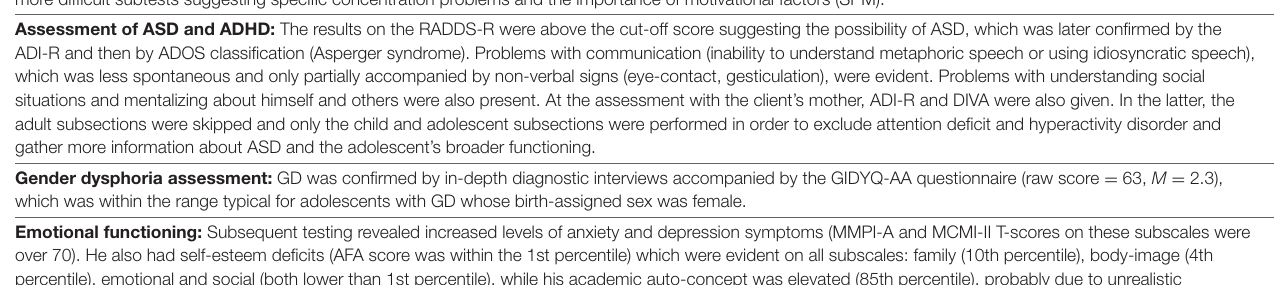
TABLE 1 | The results of the clinical psychological assessment. Intellectual and cognitive abilities : The results revealed intact visual-motor performance (BGT), average attention span and working memory, low intellectual abilities (25th percentile) with disharmonic profiles of subtests due to inconsistent mental effort and therefore lower reliability of the results. Performance was better on more difficult subtests suggesting specific concentration problems and the importance of motivational factors (SPM). Assessment of ASD and ADHD: The results on the RADDS-R were above the cut-off score suggesting the possibility of ASD, which was later confirmed by the ADI-R and then by ADOS classification (Asperger syndrome). Problems with communication (inability to understand metaphoric speech or using idiosyncratic speech), which was less spontaneous and only partially accompanied by non-verbal signs (eye-contact, gesticulation), were evident. Problems with understanding social situations and mentalizing about himself and others were also present. At the assessment with the client’s mother, ADI-R and DIVA were also given. In the latter, the adult subsections were skipped and only the child and adolescent subsections were performed in order to exclude attention deficit and hyperactivity disorder and gather more information about ASD and the adolescent’s broader functioning. Gender dysphoria assessment: GD was confirmed by in-depth diagnostic interviews accompanied by the GIDYQ-AA questionnaire (raw score = 63, M = 2.3), which was within the range typical for adolescents with GD whose birth-assigned sex was female. Emotional functioning: Subsequent testing revealed increased levels of anxiety and depression symptoms (MMPI-A and MCMI-II T-scores on these subscales were over 70). He also had self-esteem deficits (AFA score was within the 1st percentile) which were evident on all subscales: family (10th percentile), body-image (4th percentile), emotional and social (both lower than 1st percentile), while his academic auto-concept was elevated (85th percentile), probably due to unrealistic self-perceptions. Personality assessment: Projective techniques (Rorschach test, scored with Rorschach Assistance Program (Ver. 3) by Virtual Psychology) revealed further information about the client’s functioning. On the surface he was functioning quite well (Adj D = + 1), yet he seemed to be having problems with emotion regulation control (CF + C = 5, FC = 3, Afr = 0.87, a: p = 5: 2) and perception and thinking (PTI = 5, XA% = 0.5, X-% = 0.43, SumLv2 = 4, FAB2 = 3, R = 28, WSUM6 = 29, M - = 2). He seemed to be guided more by impulses than rational thinking (EB = 3: 7), which occasionally manifested in weakened impulse control (resulting in excessive food intake, for example). His reality control capacities were weak, there were indices of a schizoid withdrawal into isolation as well as the presence of hypervigilance (confirmed by HVI index). He described vivid de-realizations, occurring mainly in social situations (social anxiety in terms of ASD). Comprehensive qualitative evaluation of Rorschach test, TAT and Draw-a-Person Test revealed problems with identity differentiation and weak identity structure. Concrete thinking (Blends: R = 2: 28) and fragile self (Fr + rF = 2) with a very limited capacity for mentalization [Pure H = 1, (H) = 7, SumT = 0, GHR: PHR = 2: 7] were also features shaping his identity perception and identity expression. Due to his young age (17 years) we could not diagnose personality disorder, yet the results on MCMI-II Schizotypal subscale were increased (BR = 113) and suggested caution in further treatment and medical interventions. BGT, Bender Gestalt Test (BGT); SPM, Raven’s Standard Progressive Matrices test; RADDS-R, Ritvo Autism Aspergers Diagnostic Scale – Revised; ADI-R, Autism Diagnostic Interview;